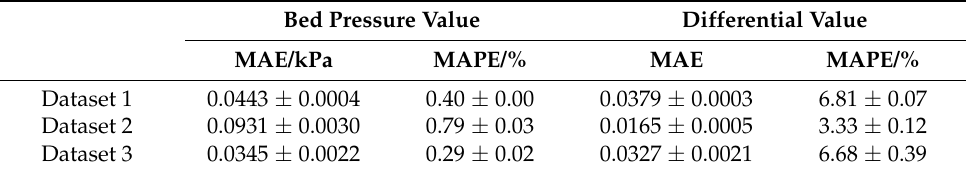
Table 6. The prediction comparison table of differential prediction